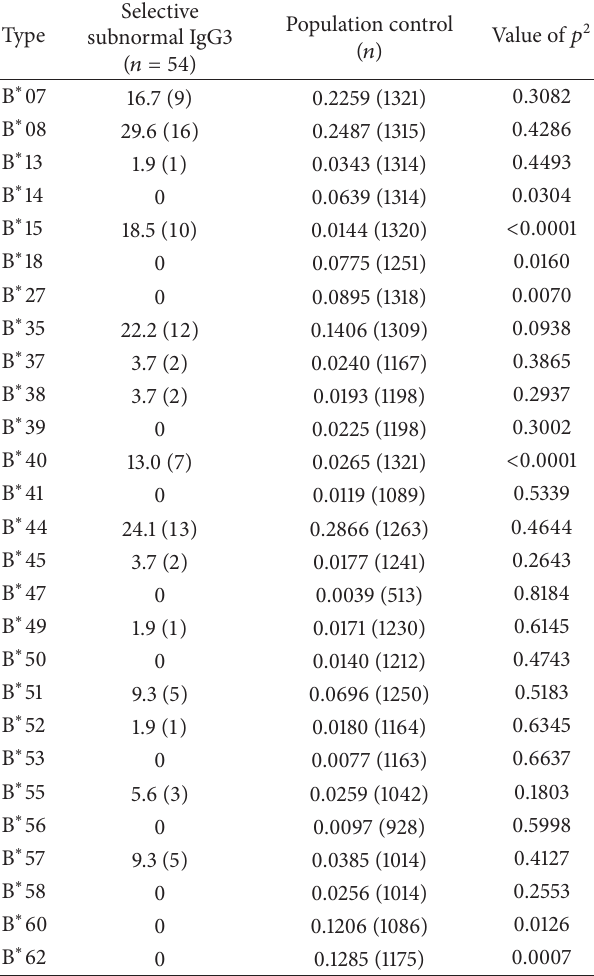
Table 3: HLA-B positivity in Alabama adults 1